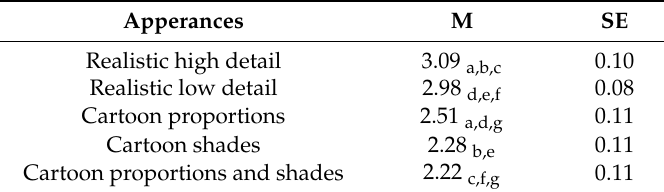
Table 1. Overall perceived realism ratings for degrees of realism.